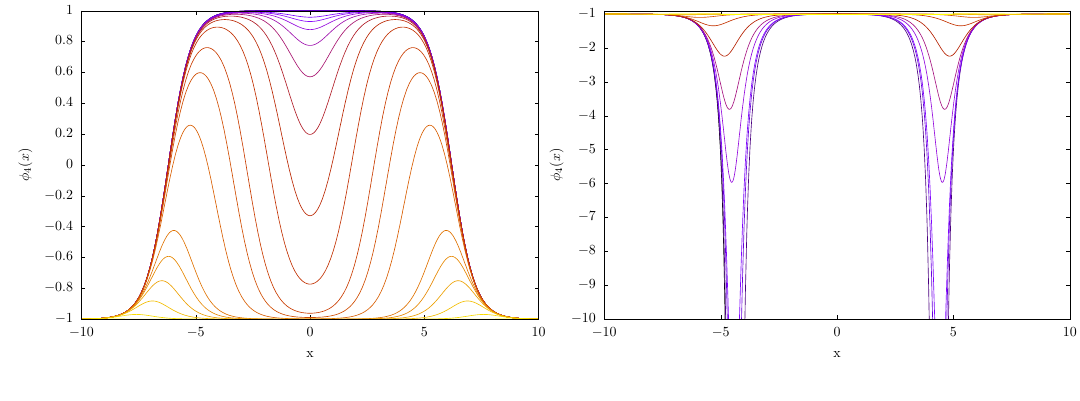
Figure 4 . Examples of (cid:30) 4